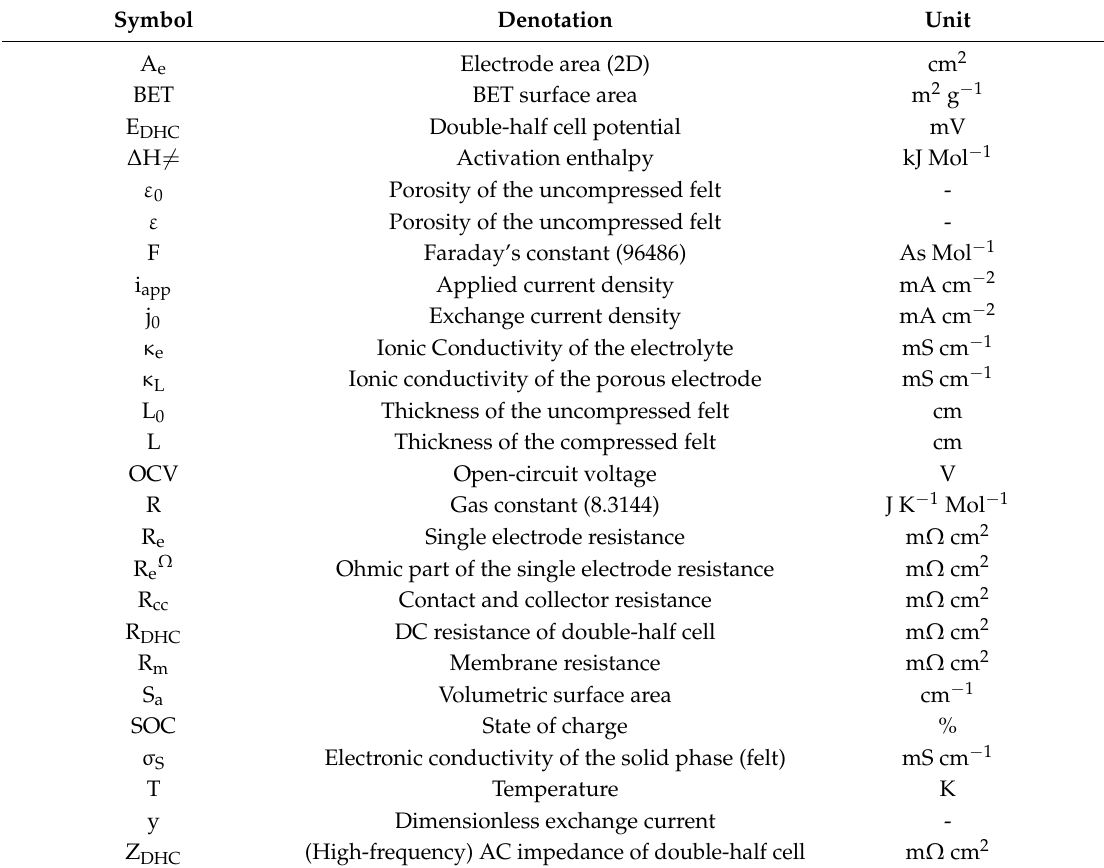
Figure S1: Difference in resistance of positive and negative DHCs using NR-211 and NR-212 membranes at different